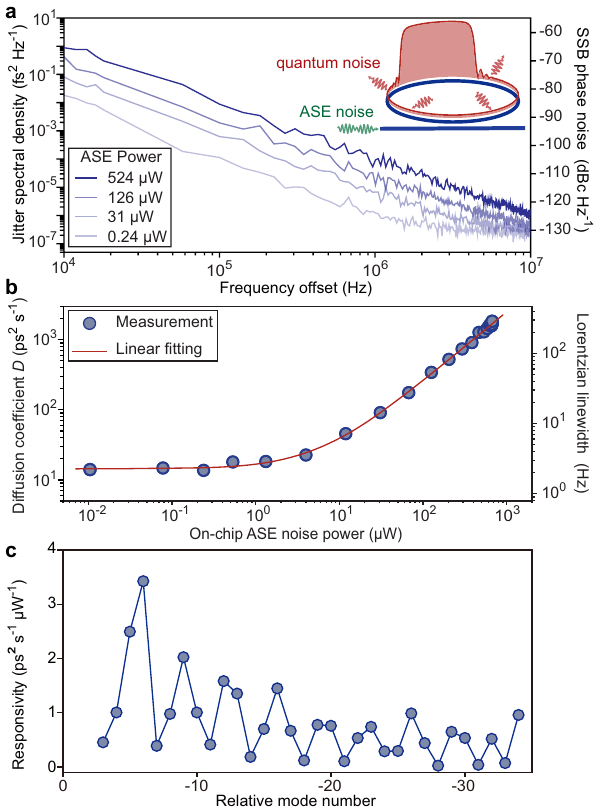
Fig.3|Diffusioncoef fi cientandresponsivity.a Jitterspectraldensityatdifferent ASE power level. ASE noise generated from an EDFA is combined with the continuous-wave pump and sent into the microresonator. b Diffusion coef fi cients (Lorentzianlinewidthofrepetitionfrequencies)versusASEpower.The red lineisa linear fi t. c Measured jitter responsivity as a function of relative mode number.